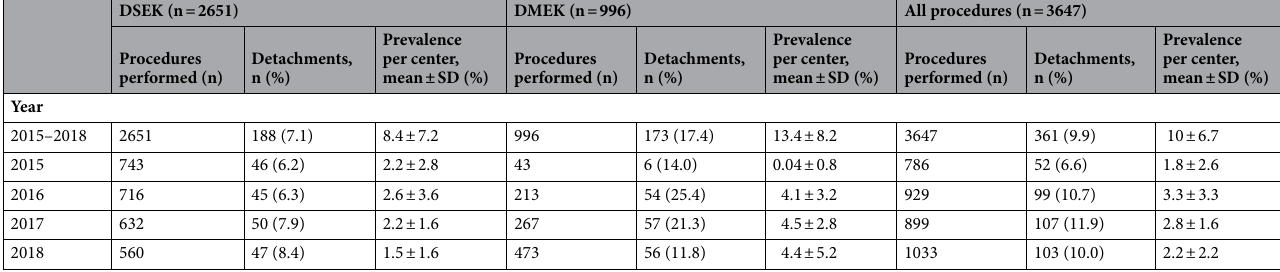
Table 1. Summary of graft detachments following DSEK and DMEK procedures performed in the Netherlands from 2015 through 2018. DSEK Descemet’s stripping endothelial keratoplasty, DMEK Descemet’s membrane endothelial keratoplasty, SD standard